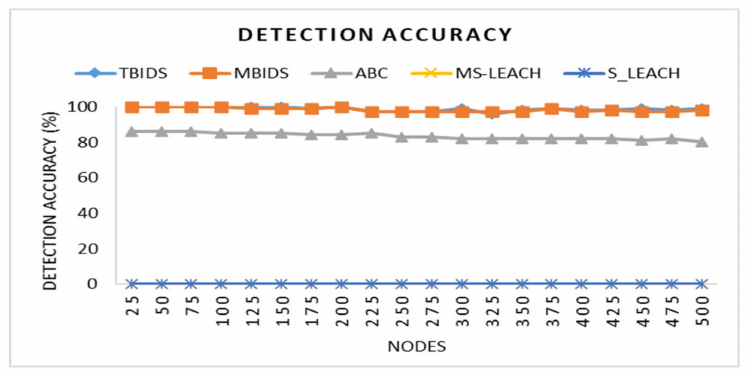
Figure 8. Two sink nodes and two